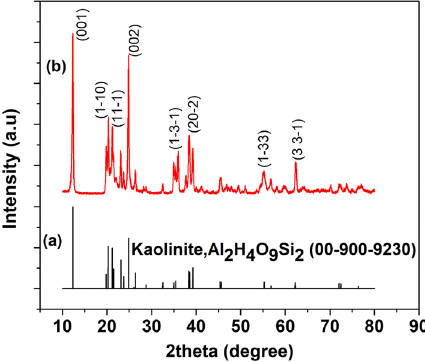
Fig. 3 Powder X-ray diffractogram of a reference kaolinite and b raw kaolin sample obtained from Hadya , Ethiopia